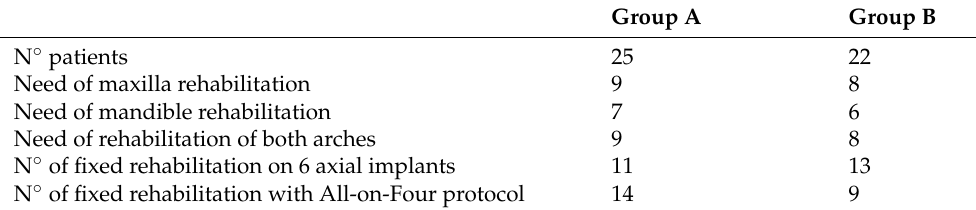
Table 1. Number of patients in each group classified according to the need for rehabilitation of the maxilla, mandible or both jaws and according to the type of rehabilitation performed (on six axial implants or on four in the All-on-Four protocol).